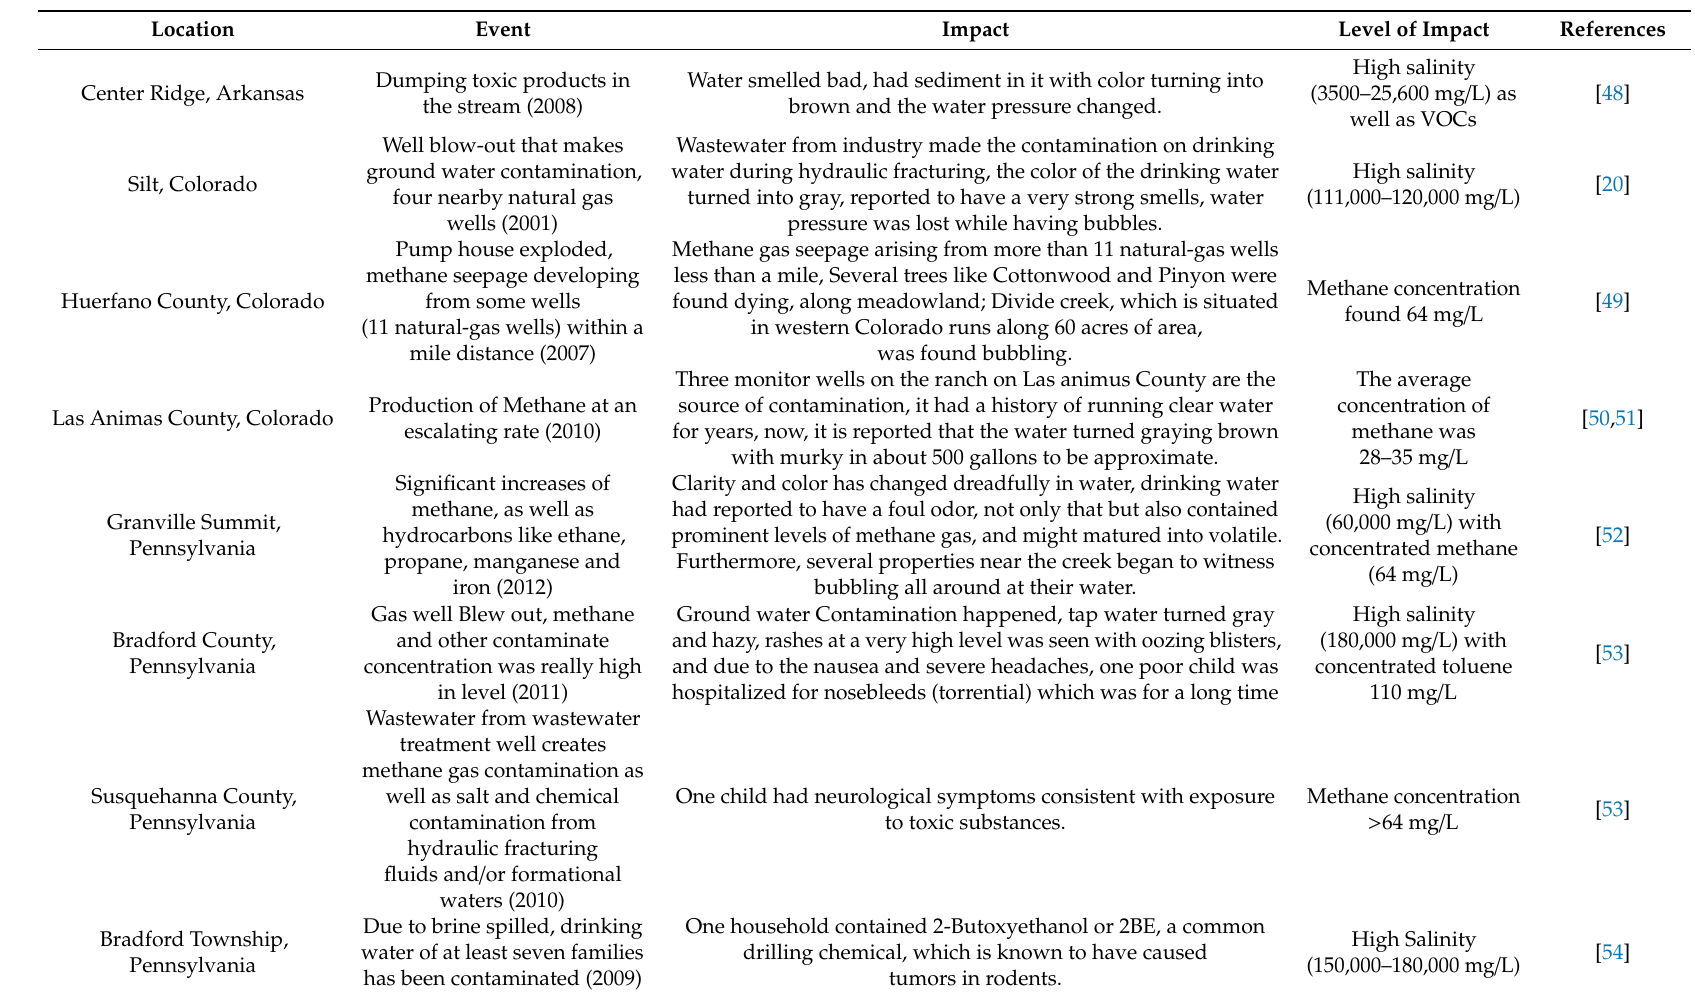
Table 1. Ground water